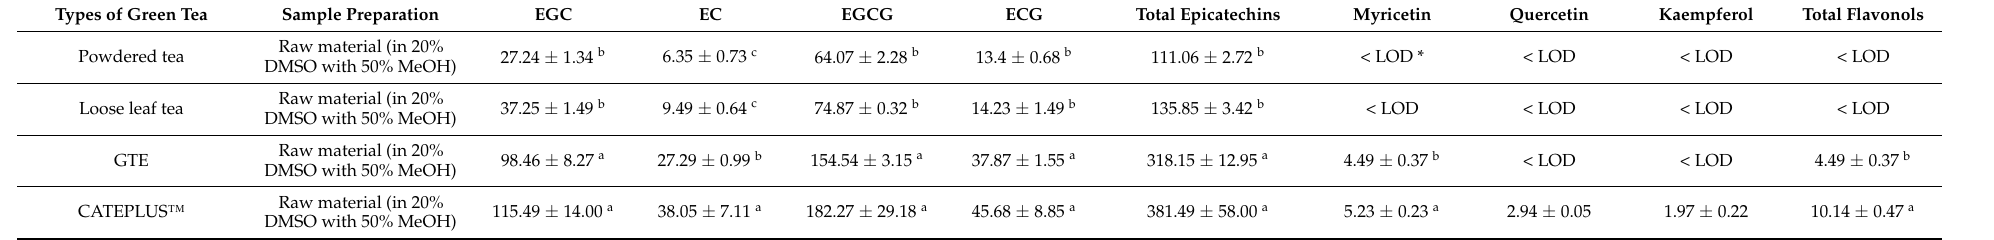
Table 1. Content of epicatechins and flavonols in commercially available raw green tea materials (product itself) (mg/g dry weight).